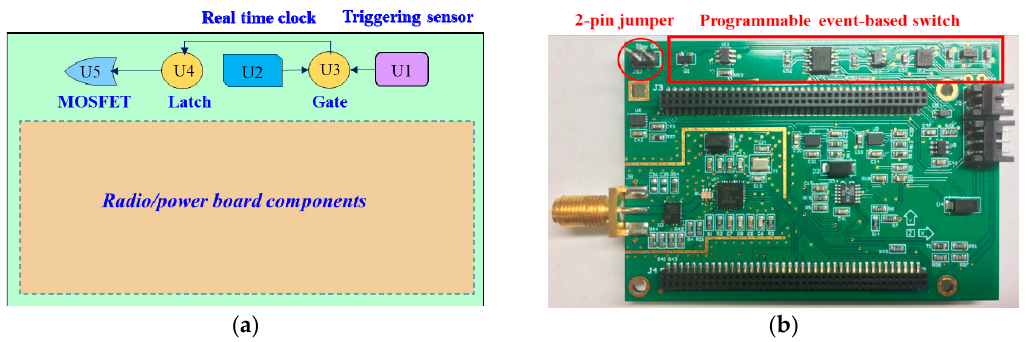
Figure 3. PCB design for the event-based switch: ( a ) design concept ( b ) realized PCB .